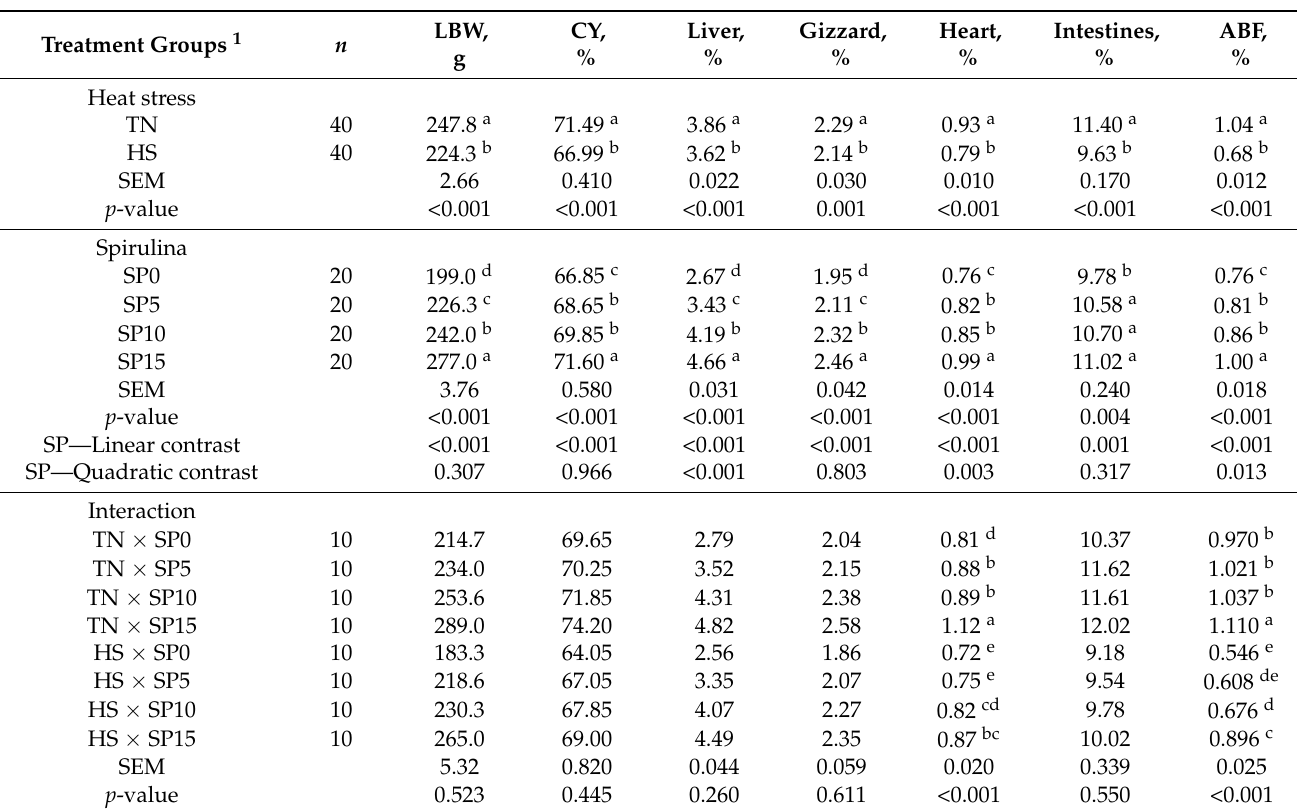
Table 4. Heat stress, spirulina, and their interaction effects on the slaughter performance of Japanese quail